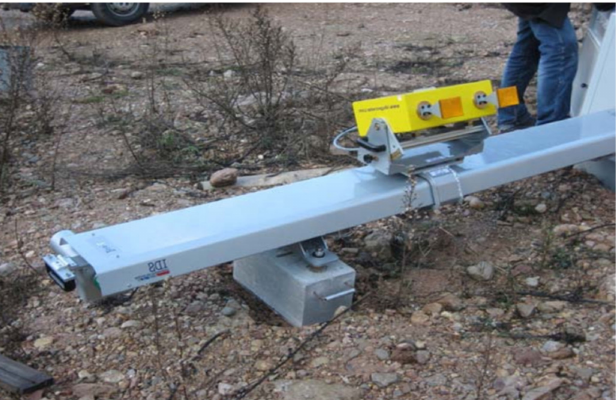
Figure 18. Picture of the IDS GBSAR system. The synthetic aperture is obtained through the movement of the radar sensor (yellow box) along the rail.